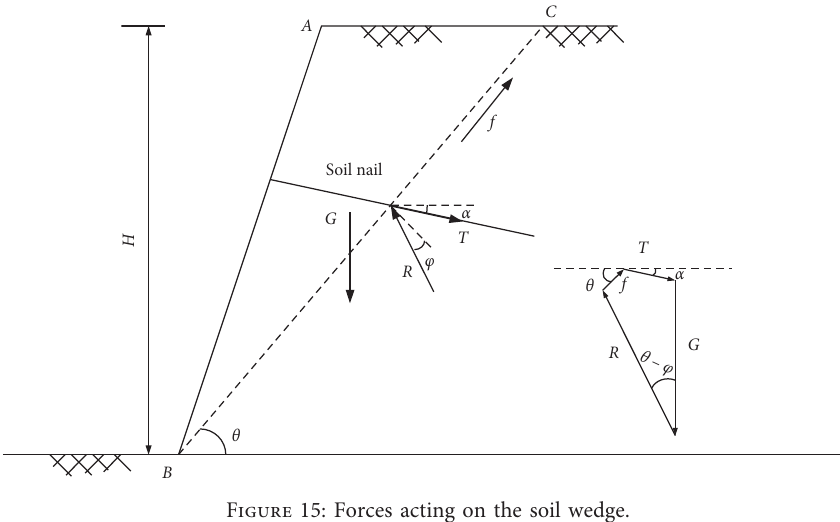
Figure 15: Forces acting on the soil wedge.